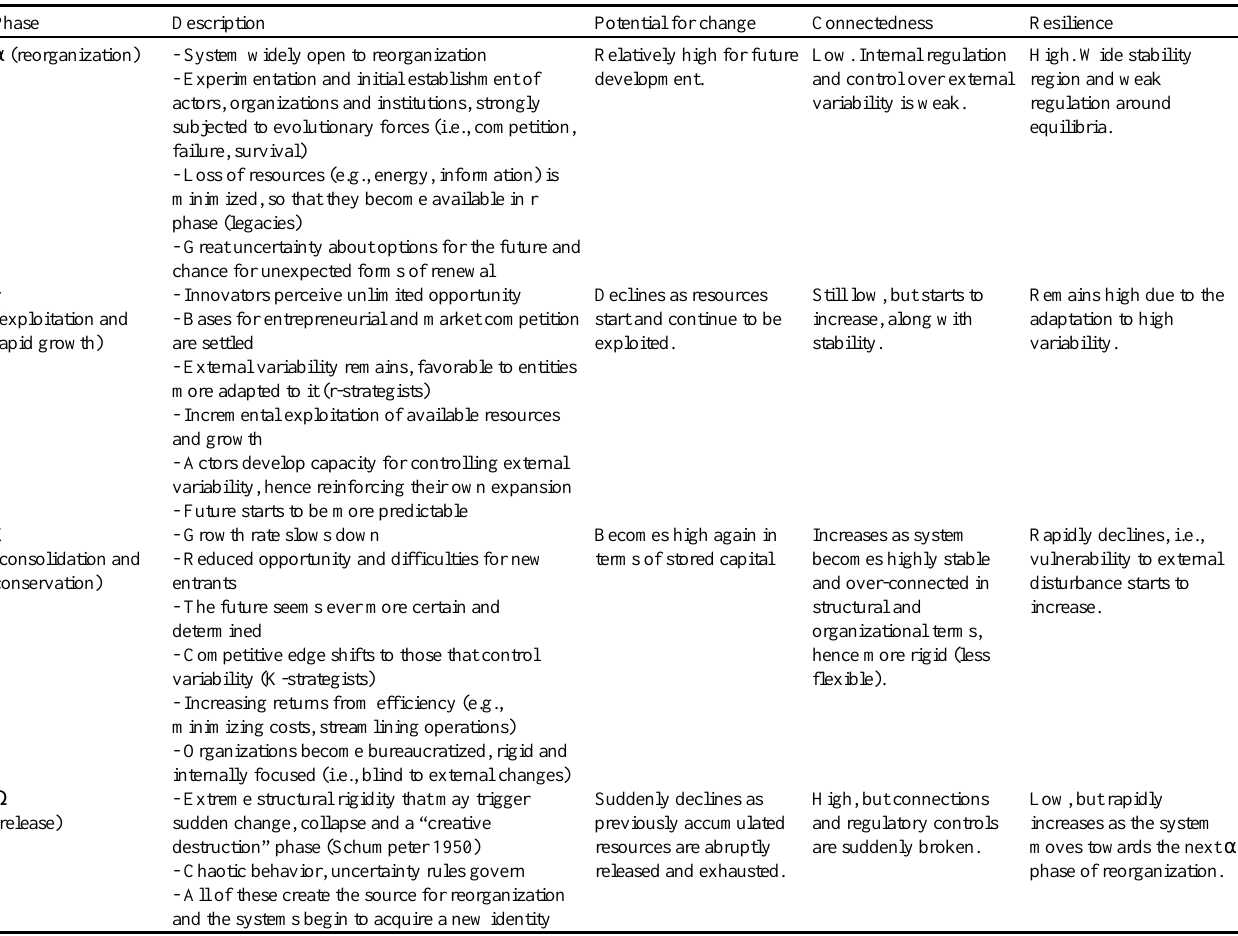
Table 2 . Description of the four phases of the adaptive cycle and the associated changes in the system's descriptive properties: potential for change, connectedness, and resilience (Gunderson and Holling 2002).